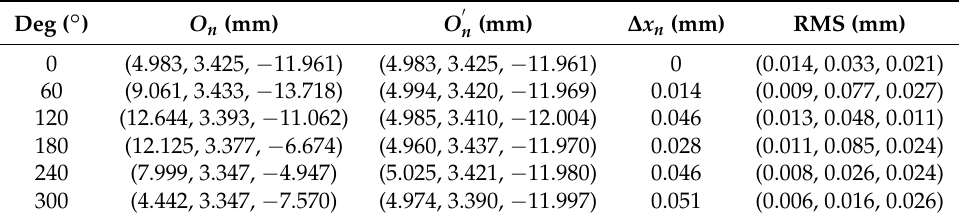
Table 3. The results of inverse calculation error by correcting 6 angles of view.